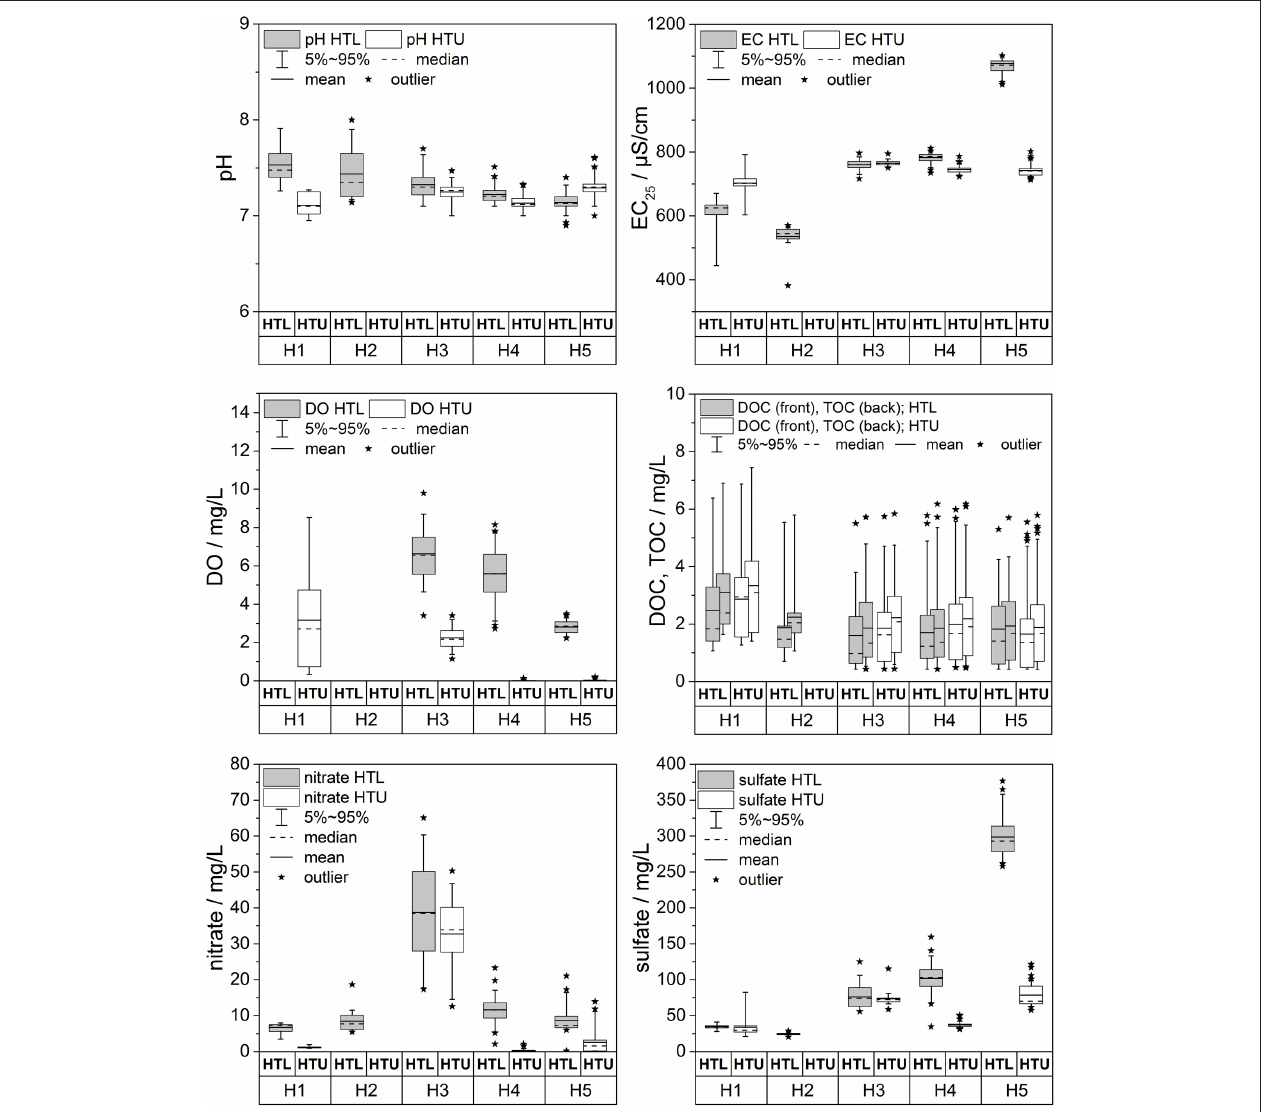
FIGURE 9 | Box-Whisker plots of selected chemical parameters (pH, electrical conductivity, dissolved oxygen (DO), dissolved organic carbon (DOC), total organic carbon (TOC), sulfate and nitrate) sampled at HTL and HTU along the five groundwater sampling sites (H1-H5). Data are based on samples taken during 2013 through